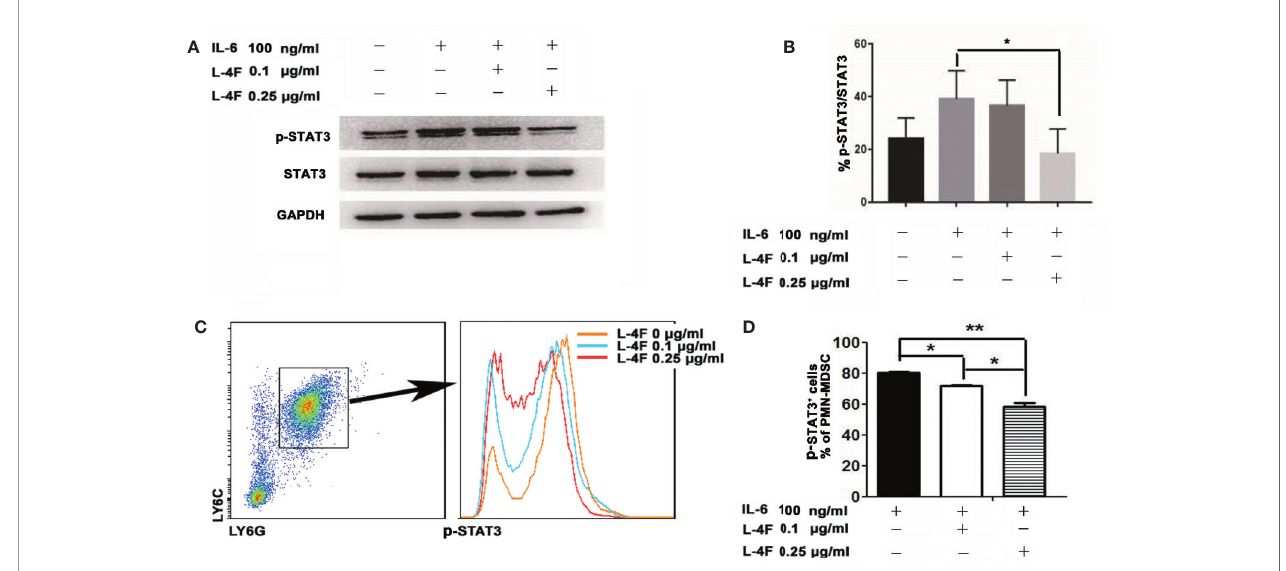
FIGURE 6 | L-4F downregulates STAT3 signaling pathways in PMN-MDSCs Mouse MDSCs were induced in vitro . On the fourth day, the cells were incubated with L-4F at a concentration of 0, 0.1, and 0.25 m g/ml for 12 h, and then stimulated with concentration of 100 ng/ml recombinant mouse IL-6 for 15 min. (A) One representative result from each experiment is shown. (B) The ratio of p-STAT3/STAT3 in MDSCs (*P < 0.05). MDSCs were isolated from the spleen and tumor tissue from pancreatic cancer mouse model using anti-mouse Ly-6G and Ly-6C particles-DM. The MDSCs were incubated with L-4F at a concentration of 0, 0.1, and 0.25 m g/ml for 12 h, then stimulated with concentration of 100 ng/ml recombinant mouse IL-6 for 15 min. (C) One representative result from each experiment is shown. (D) The percentage of p-STAT3 in PMN-MDSCs (**P < 0.01, *P <